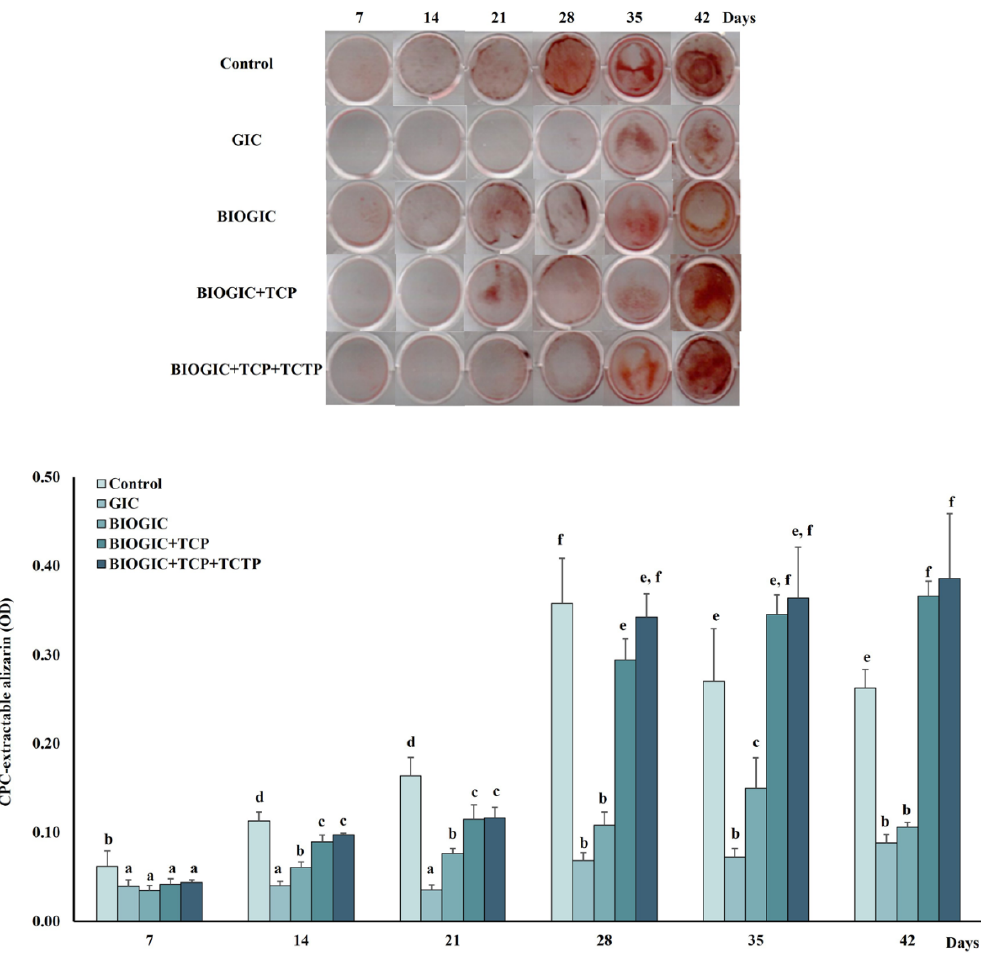
Figure 10. Odontogenic mineralization potential of hDPSCs. The mineralization was measured by alizarin red S staining, hDPSCs were cultured on the specimens for 7, 14, 21, 28, 35, and 42 days. Data are represented as mean ± SD. Different lowercase letters represent significant difference at p < 0.05, one-way ANOVA with Tukey multiple comparison test ( n = 6 in each group).